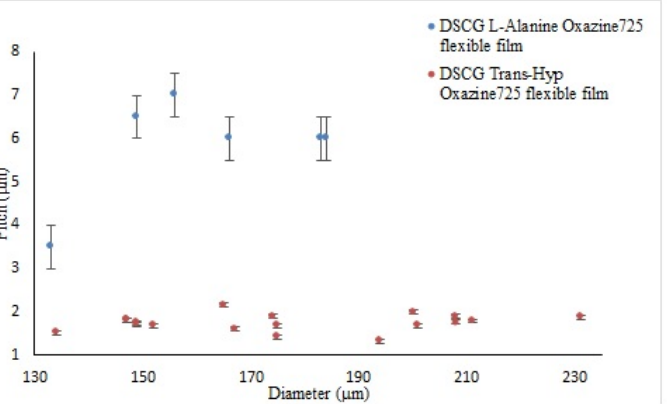
Figure 10. Cholesteric half-pitch as a function of microsphere diameter for oxazine-doped DSCG + L-alanine (blue), and oxazine-doped DSCG + Trans-Hyp (orange). Storage at 4 ◦ C allows maintenance the textures for at least 10 days, after which the microsphere degradation process